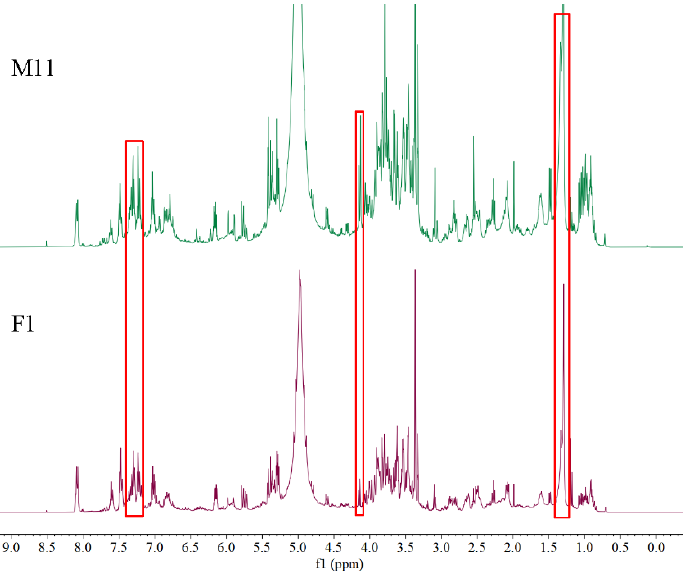
Figure 2. Representative 1 H NMR spectra of female (F1) and male (M11) flower buds of P. tomentosa with the same amplification degree.